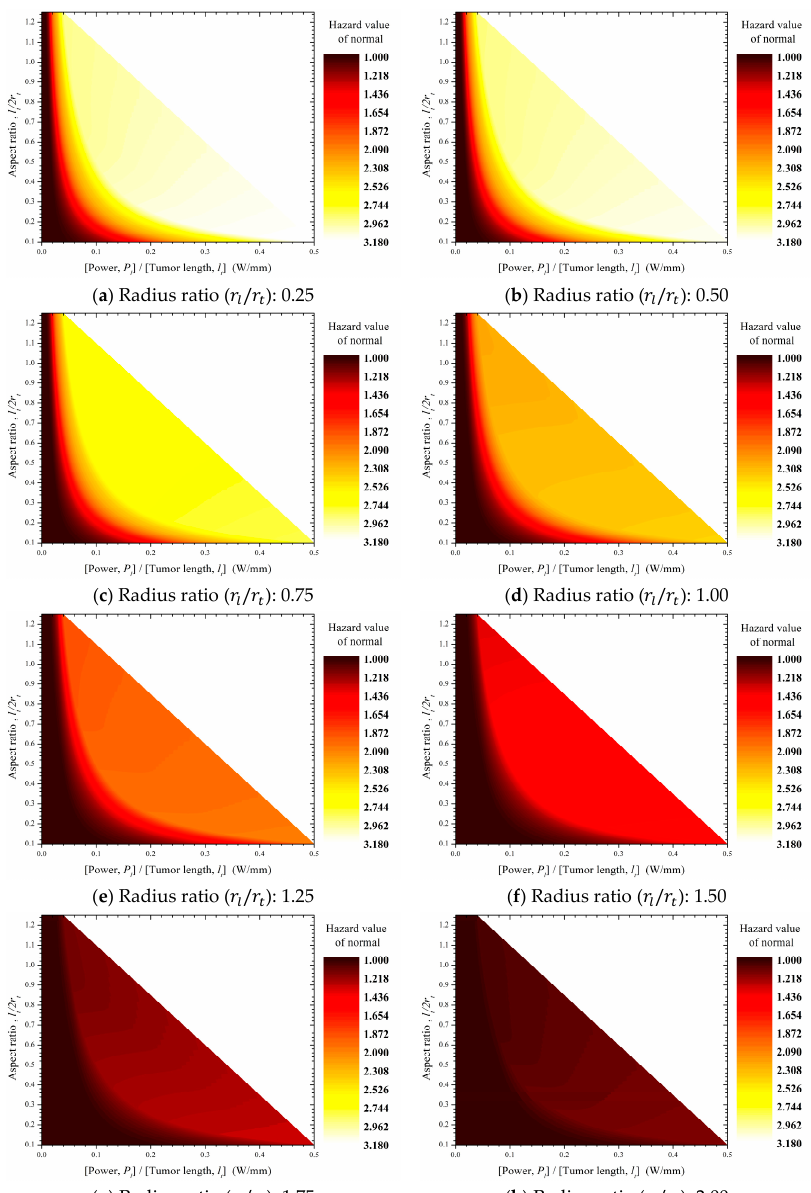
Figure 11. Contour graphs showing the thermal hazard values of normal tissues ( 𝜃 (cid:3009),(cid:3041) ). An analysis of the apoptosis ratio ( 𝜃 (cid:3002) , Figure 8) in tumor tissues revealed that the hazard value of normal tissue was approximately in the range of 1–1.3 for the tumor aspect ratio ( 𝑙 (cid:3047) /2𝑟 (cid:3047) ) and laser